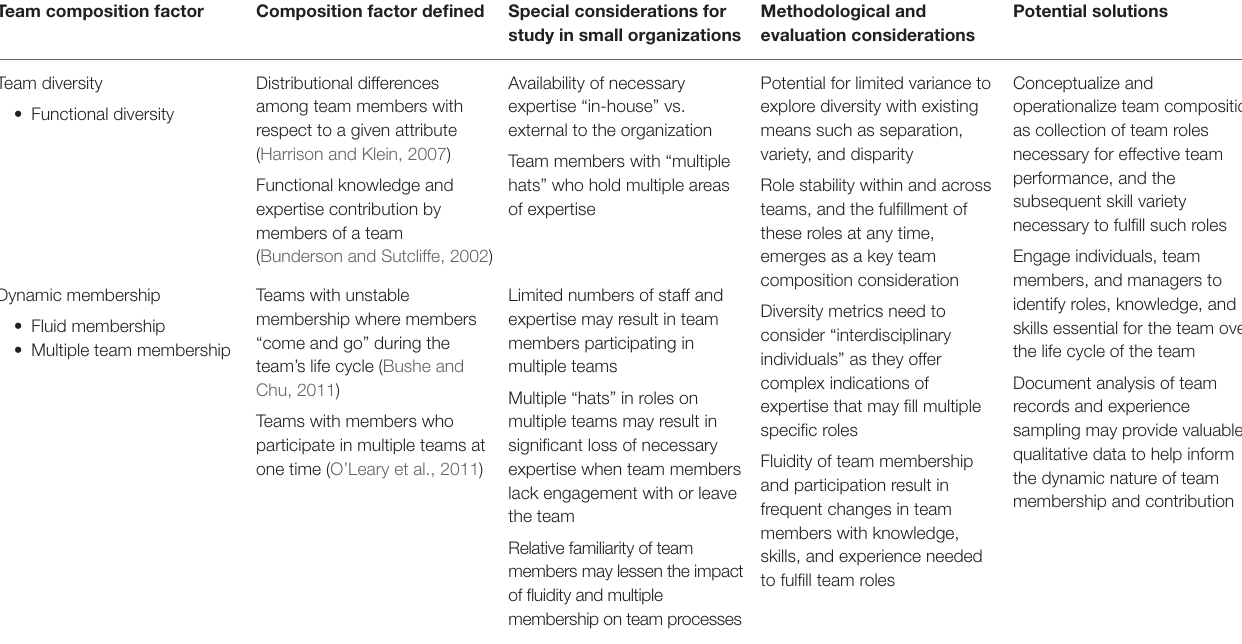
TABLE 2 | Team composition methodological considerations for teams in small organizations. Team composition factor Composition factor defined Special considerations for